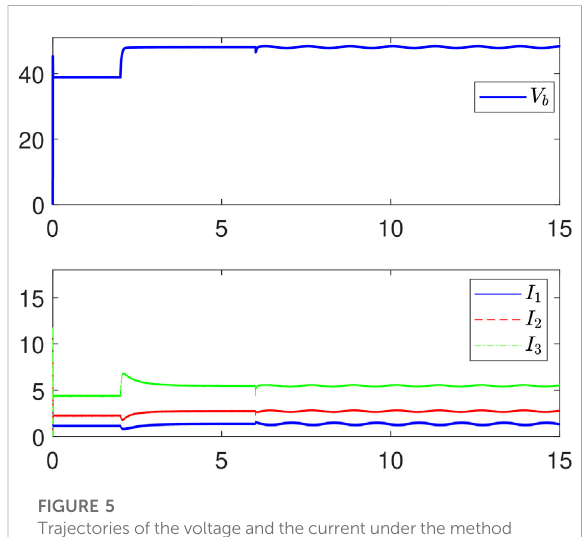
FIGURE 5 Trajectories of the voltage and the current under the method in Lian et al.